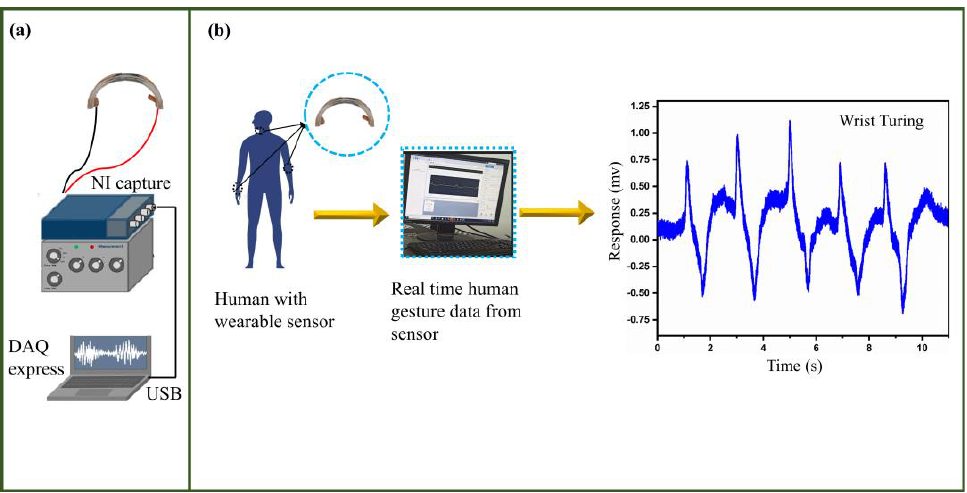
Figure 1. Schematic of the data collection. ( a ) Experimental setup of the sensor. ( b ) Data collection and extraction from the sensor.